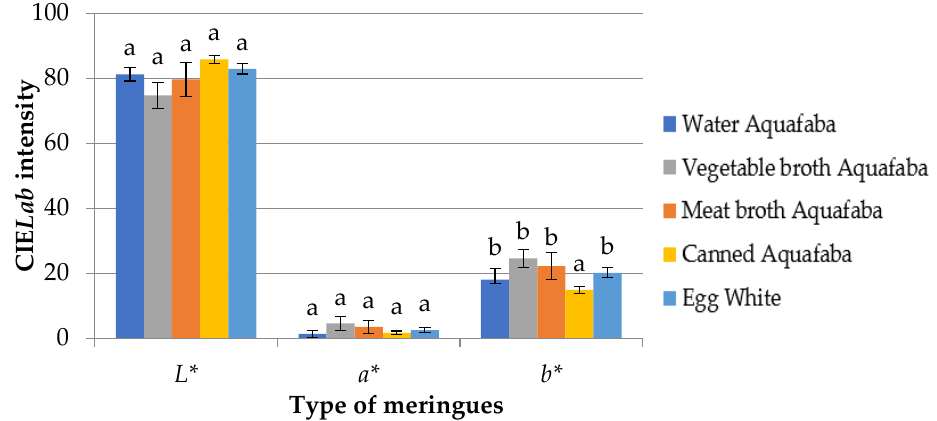
Figure 4. Mean values of CIE Lab parameters in meringues made with four types of Pedrosillano chickpea aquafaba and egg white. Luminosity ( L *), red-green ( a *), yellow-blue ( b *). a,b Means for each CIE Lab parameter with different superscripts showed significant differences ( p < 0.05).